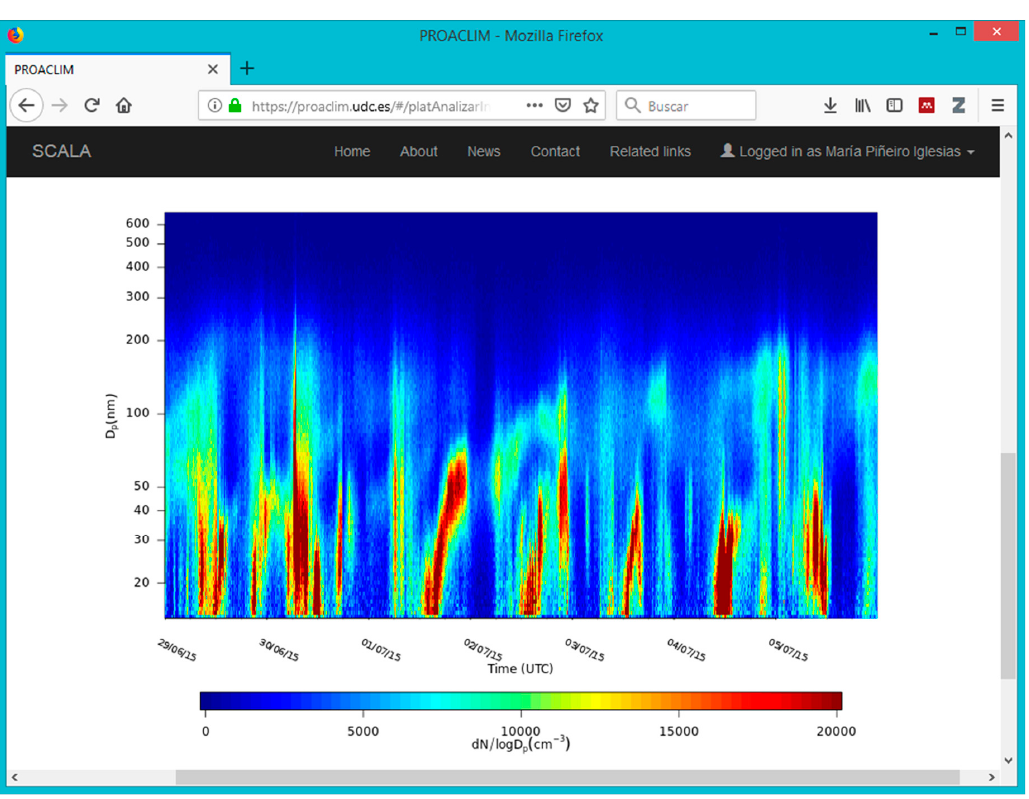
Figure 9. A surface plot showing the evolution of the particle size distribution during a week (29 June–5 July 2015).